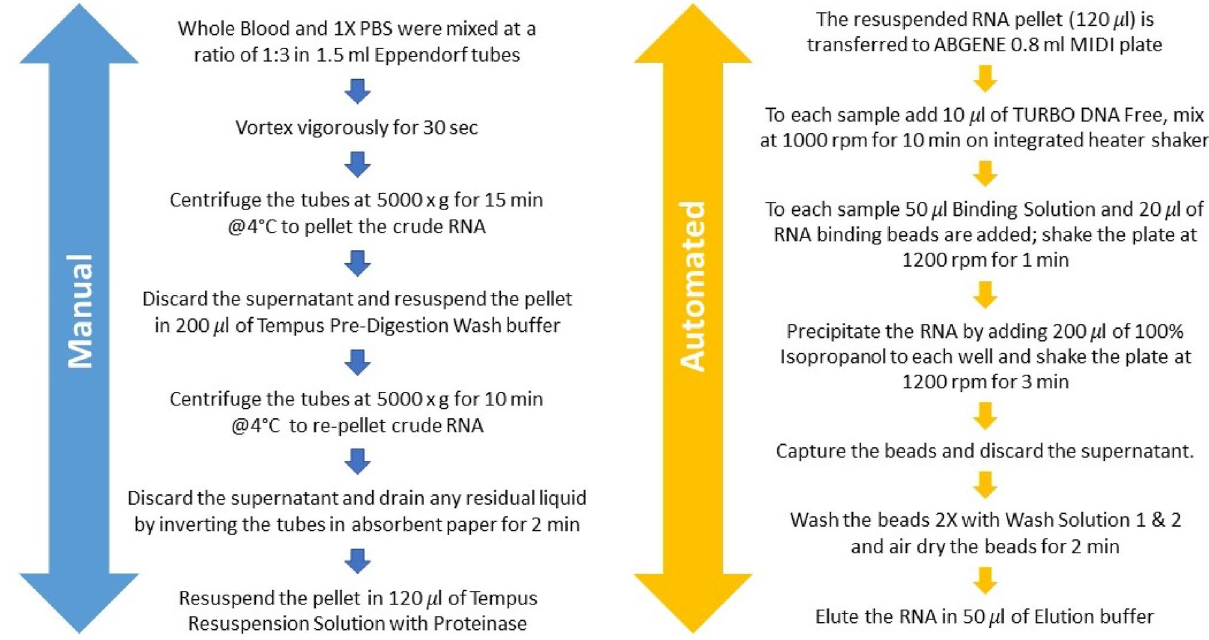
Figure 2. Overview of the manual (blue) and automated (yellow) steps included in the in-house RNA extraction of the MagMax